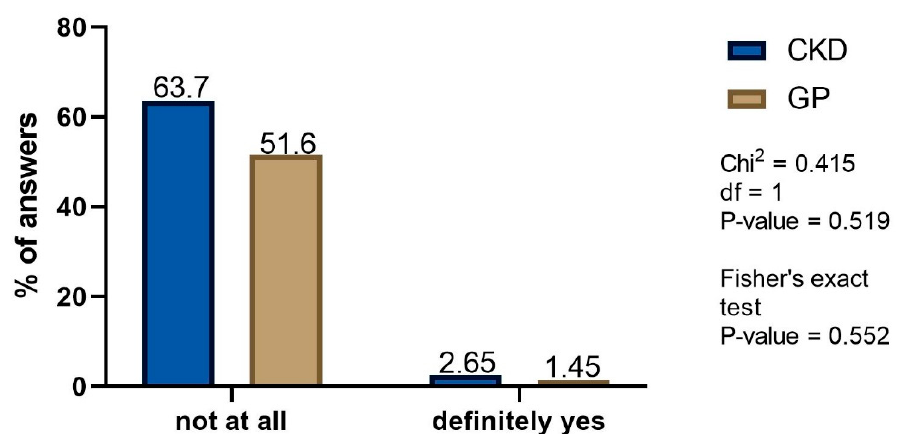
Figure 6. The influence of advertisements on the decision to take NSAIDs or analgesics: CKD— frequency of advertisement—driven decision making; GP—grading of the belief that advertisement is important (merged questions). Only definitive answers are presented.